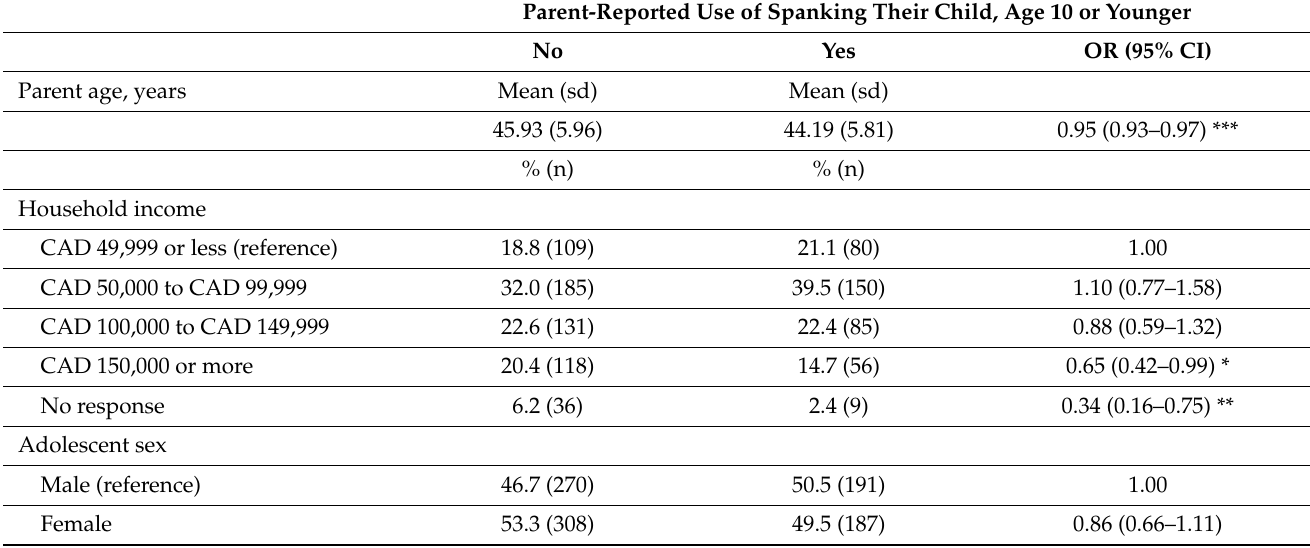
Table 1. Sociodemographic characteristics of the sample stratified by parent-reported spanking.